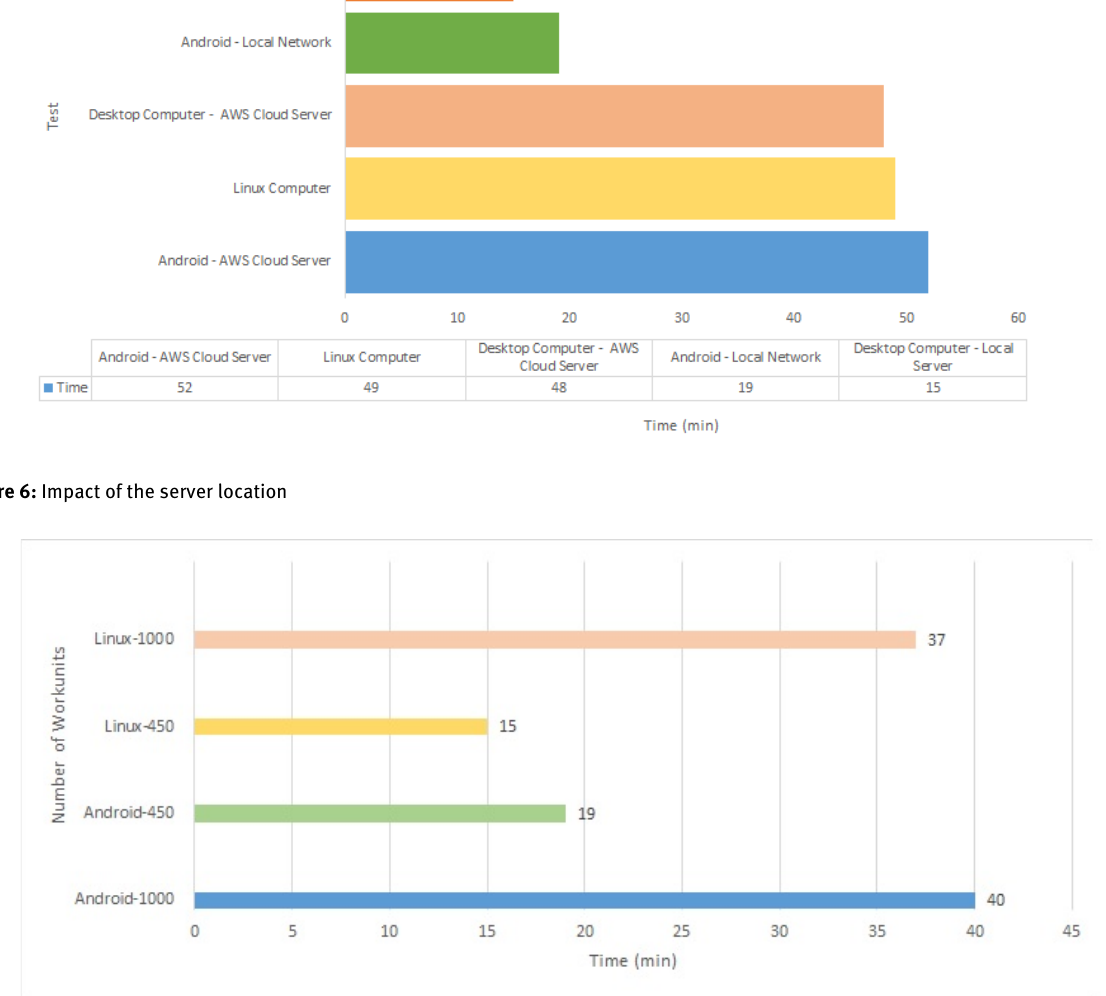
Figure 7: Impact of the degree of parallelism